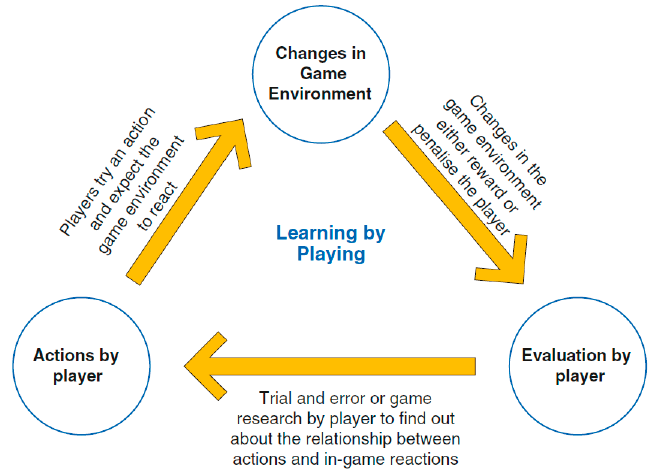
Figure 6. Learning by doing flowchart.